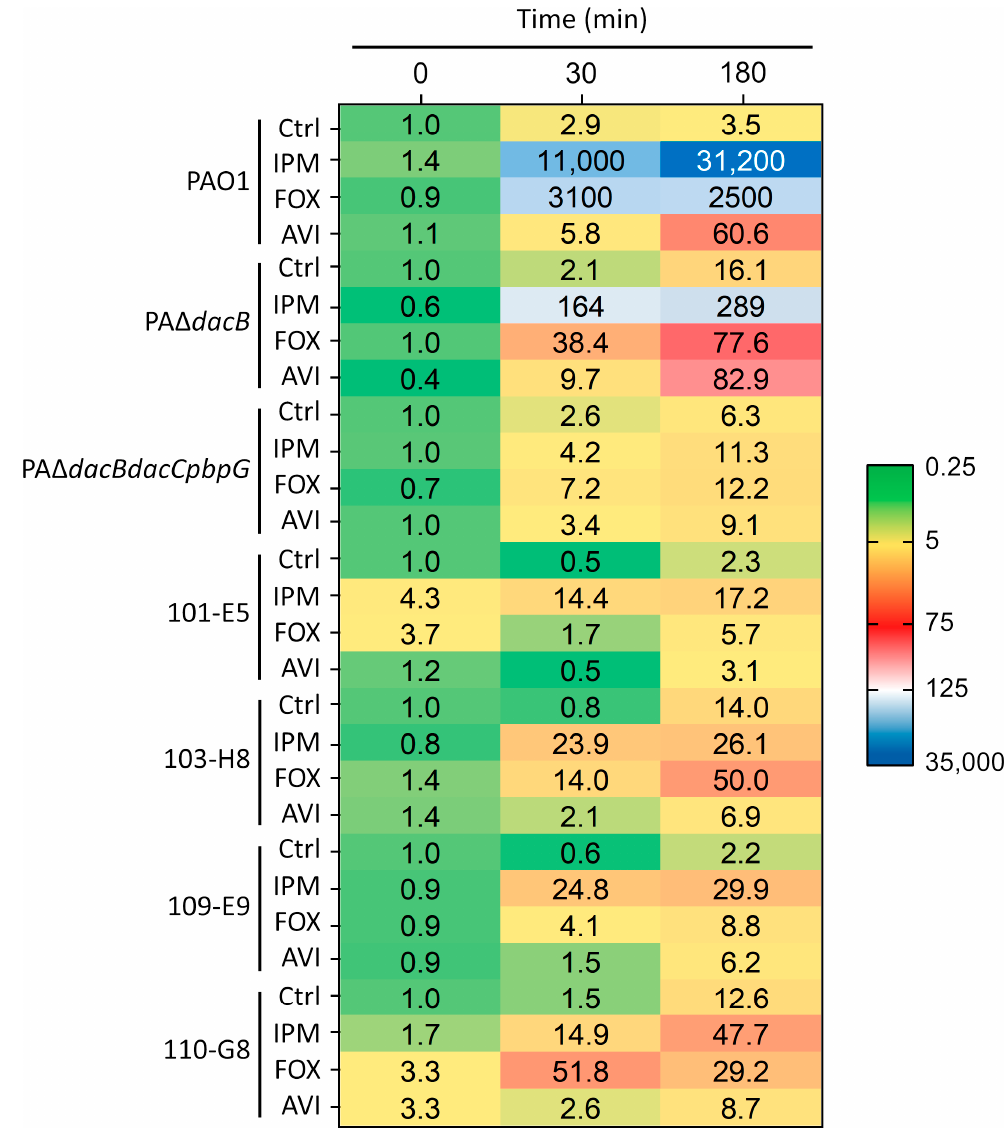
Figure 3. Relative ampC qRT-PCR expression under basal conditions (Ctrl) and after induction with 8 µg/mL imipenem (IPM), 64 µg/mL cefoxitin (FOX) and 16 µg/mL avibactam (AVI) in strains PAO1, PA Δ dacB (PBP4 knockout mutant), PA Δ dacBdacCpbpG (PBP4, 5/6 and 7 triple knockout mutant), 101-E5 and 109-E9 (OprD Q142X, AmpR G154R) CAZ/AVI sensitive ST175 high-risk clone clinical isolates and 103-H8 (AmpC E247K; PDC-221) and 110-G8 (AmpC DelG229–E247; PDC-223) CAZ/AVI-resistant ST175 high-risk clone clinical isolates. Differentially expressed ampC levels at times 0, 30 and 180 min relative to each strain basal initial determination (Ctrl; time = 0 min) are shown. Results are averages of at least two sets (biological replicates) of two technical replicates.